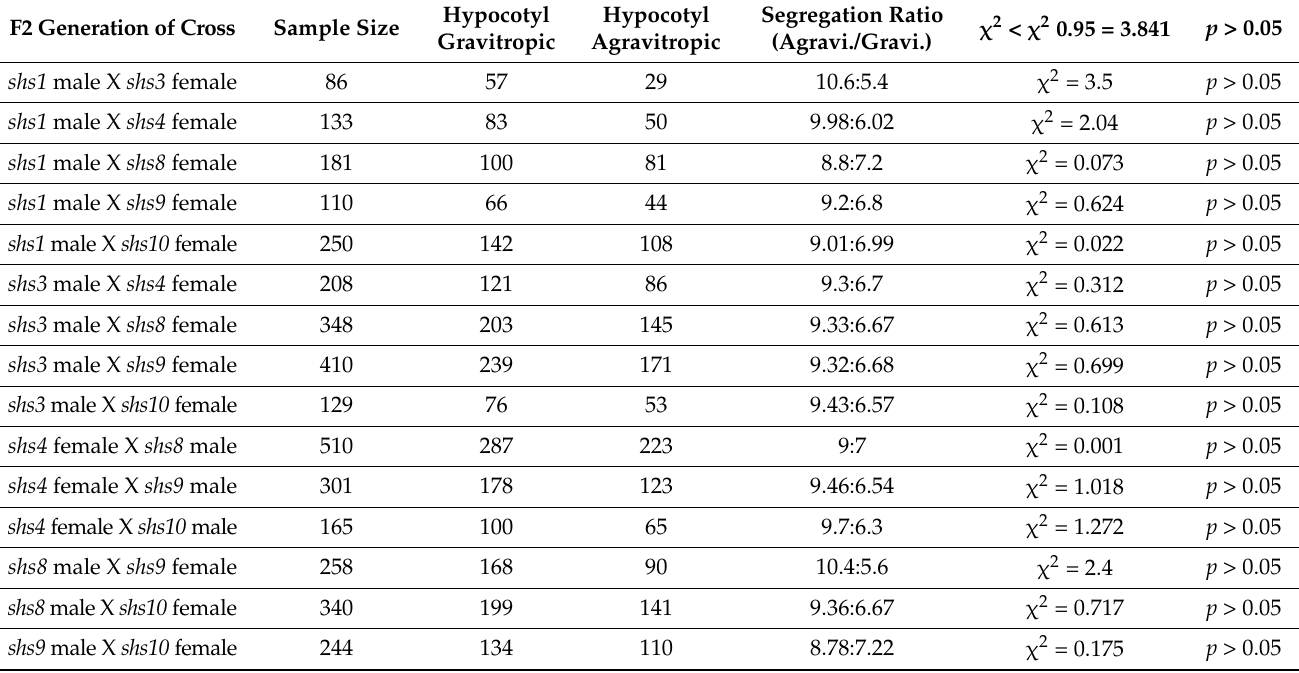
Table 3. Complementation test analysis of A. thaliana hypocotyl gravitropic suppressors. F2 gener- ation progenies of crossed suppressors were analyzed to test the hypocotyl agravitropic/gravitropic ratio. χ 2 < 3.84 is nonsignificant at 0.05 probability level.